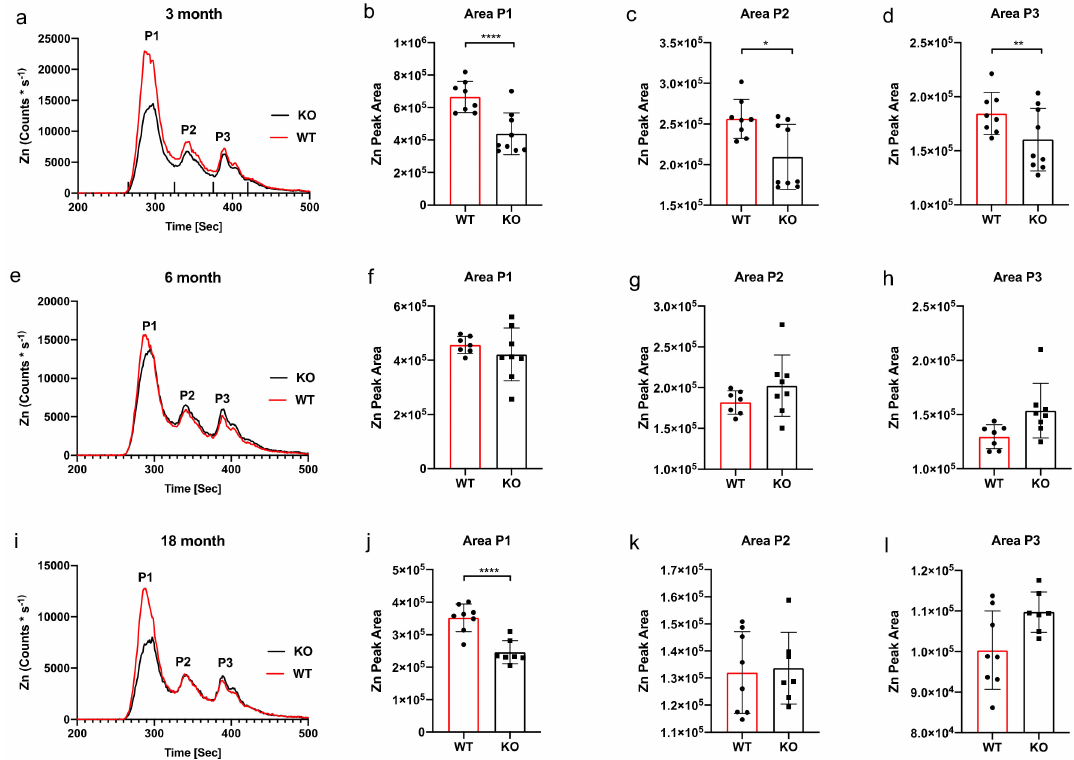
Figure 2. ICPMS and area under the curve Zn66 analysis. A di ff erence in Zn was observed between WT and KO mice at the 3-month time point chromatogram ( a ). AUC analysis of peak 1 ( b ) revealed a significant decrease (**** p < 0.0001) between WT and KO, as did peak 2 (** p = 0.04) ( c ) and no significant di ff erence for peak 3 ( d ). The ticks above the x-axis indicate the integration windows for the AUC analysis. No significant di ff erence in Zn was observed between WT and KO mice at the 6-month time point ( e ), a result reflected in the analysis of the peak area for each major peak; peak 1 ( f ), peak 2 ( g ) and peak 3 ( h ). There was a decrease observed in the ICPMS chromatogram peak 1 for KO mice at the 18-month time point ( i ) that was revealed to be significant (* p < 0.0001) ( j ). Peak 2 ( k ) and peak 3 ( l ) revealed no significant di ff erences between WT and KO. Dot plots and bar graph show the mean and SD, peak area statistical comparison one-way ANOVA Sidak’s multiple comparison